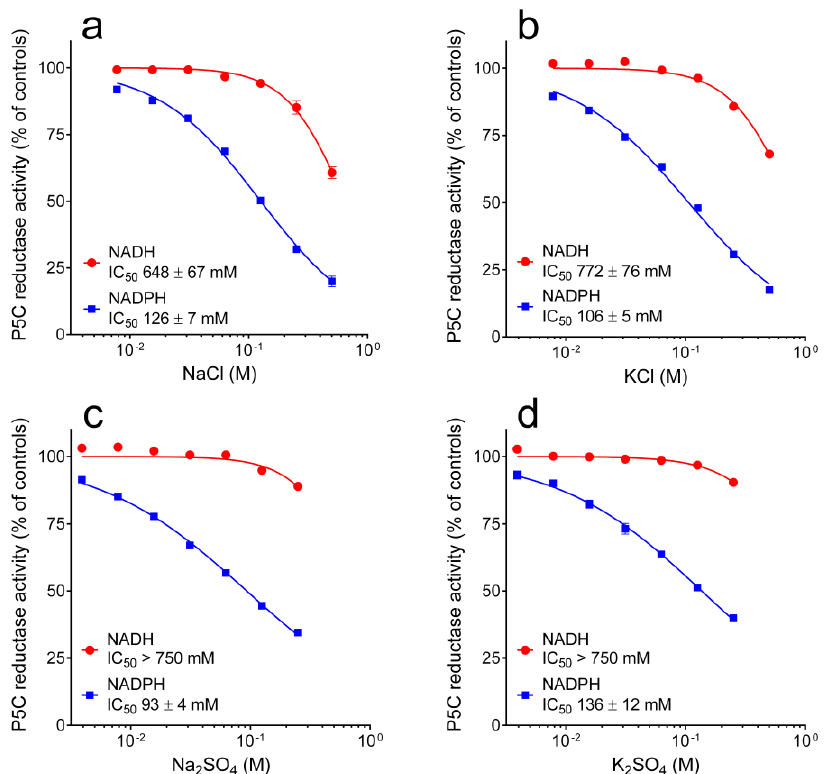
Figure 6. Effect of cations and anions on the activity of yeast P5C reductase. The purified enzyme was assayed in the absence or in the presence of increasing concentrations of chlorides (Panels a and b ) or sulfates (Panels c and d ), using either NADH or NADPH as the electron donor. Results were expressed as percent of the activity obtained with untreated controls. Data are means ± SE over three replicates.